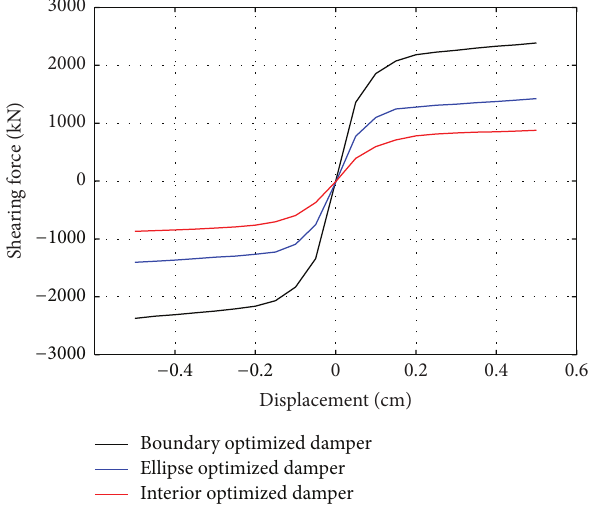
Figure 17: Skeleton curves of different dampers.